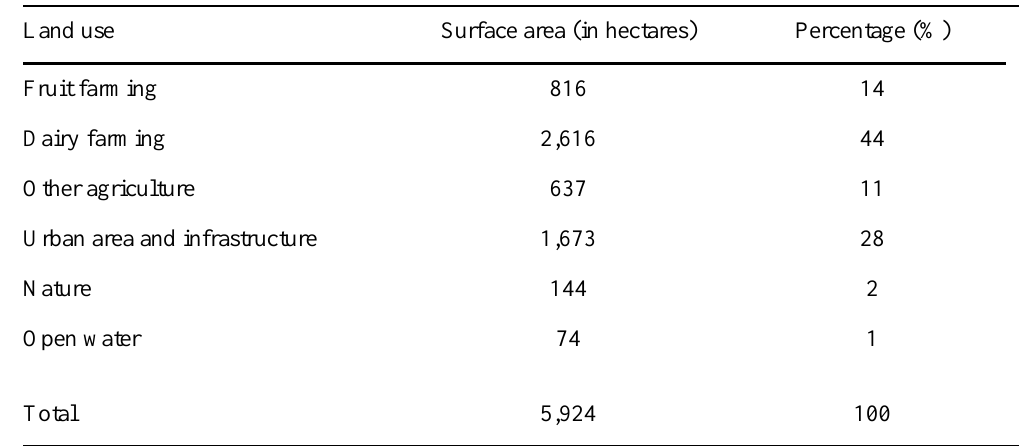
Table 1. Land use in the Kromme Rijn